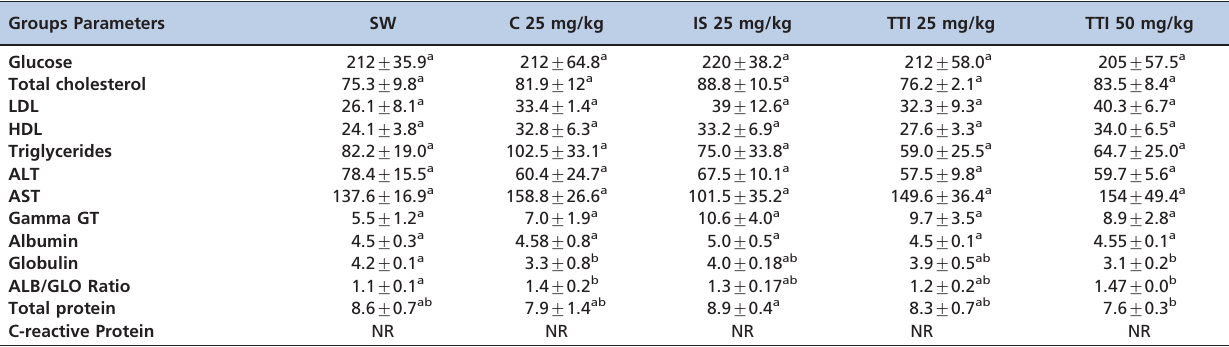
Table 3 - Biochemical parameters in Wistar rats fed the standard diet, AIN-93G + 1 mL of water (SW, n =6), AIN- 93G + 25 mg/kg casein in 1 mL water (25 mg/kg C, n= 6), AIN-93G + 25 mg/kg soybean trypsin inhibitor in 1 mL water (25 mg/kg IS, n= 6); AIN-93G + 25 mg/kg tamarind trypsin inhibitor in 1 mL water (25 mg/kg TTI, n =6), and AIN- 93G + 50 mg/kg tamarind trypsin inhibitor in 1 mL water (50 mg/kg TTI, n= 6) for 11 days. The results are expressed as the mean ¡ standard deviation of each group. Different letters indicate p , 0.05 between groups; one-way ANOVA followed by Tukey’s post-hoc test was